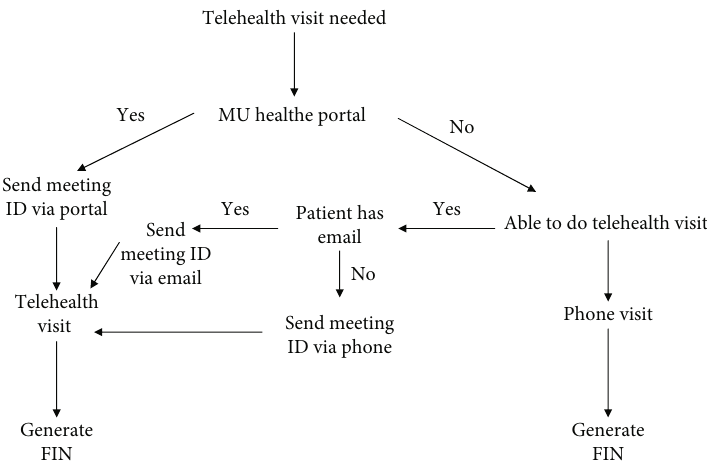
Figure 2: The work fl ow process for scheduling a telehealth visit by patient safety representatives (PSRs). FIN generated